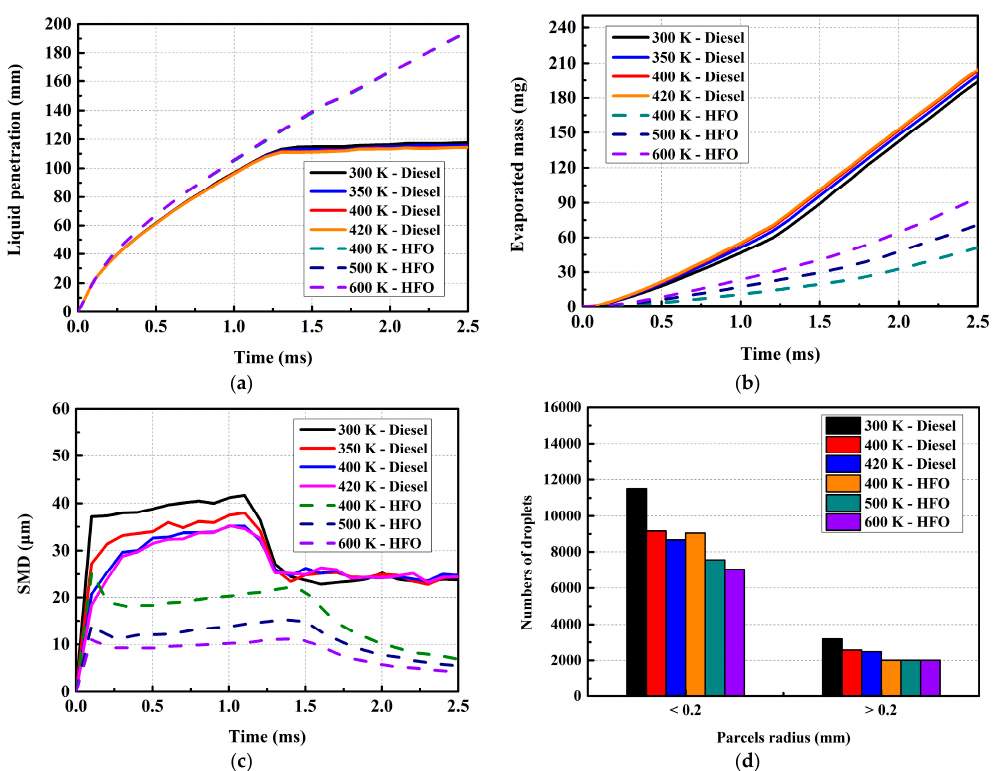
Figure 8. Comparison of diesel and HFO spray characteristics under different fuel temperatures. ( a ) Liquid penetration; ( b ) Evaporated mass; ( c ) SMD; ( d ) Parcel radius.